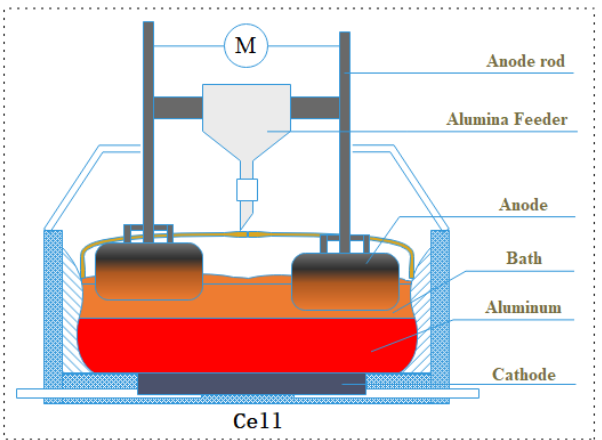
Figure 1. Structure diagram of modern aluminum reduction cell.